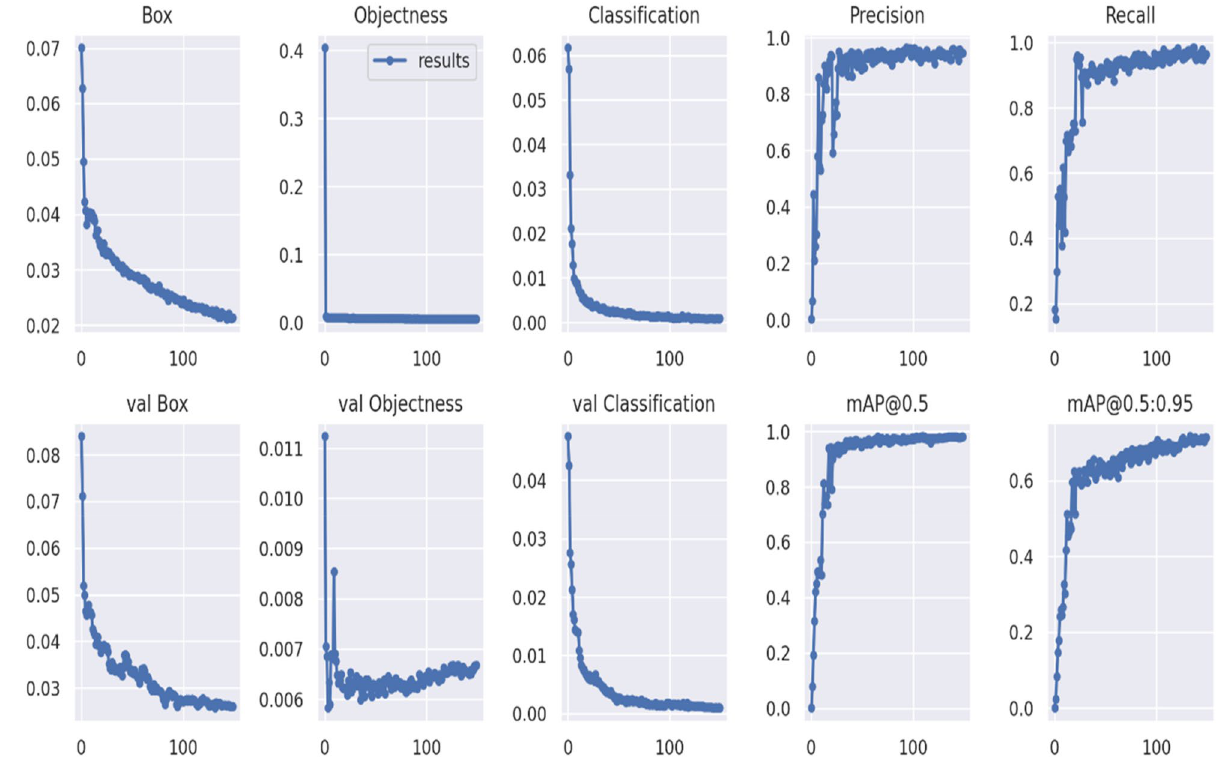
Figure 7. Visual analysis of model evaluation indicators (Precision, recall, and mAP@0.5 for the proposed YOLOv7) during